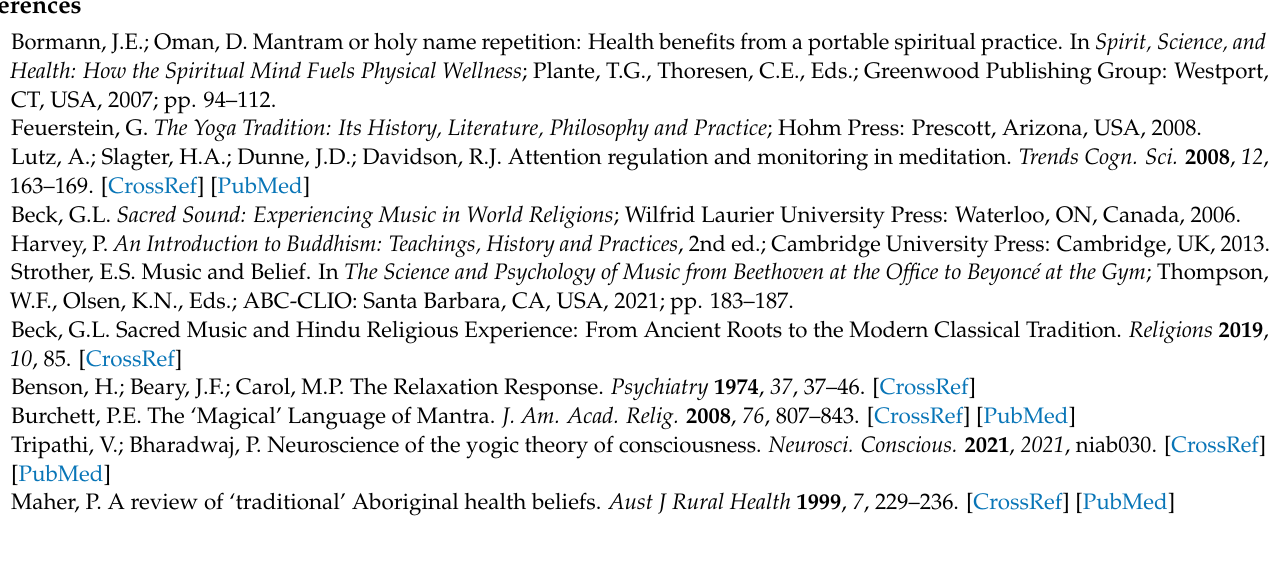
Table S3. Distribution of Religions; Table S4. Regression Table; Figure S1. Distribution of Countries Pie Chart; Figure S2. Distributions of Nationalities Pie Chart; Figure S3. Distribution of Religions Pie